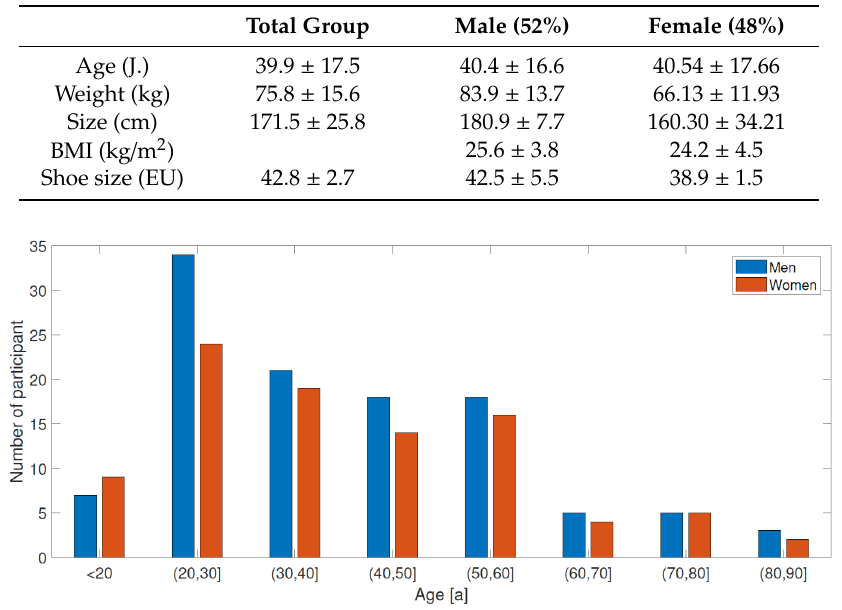
Table 1. Anthropometric data of the volunteers, broken down by gender.